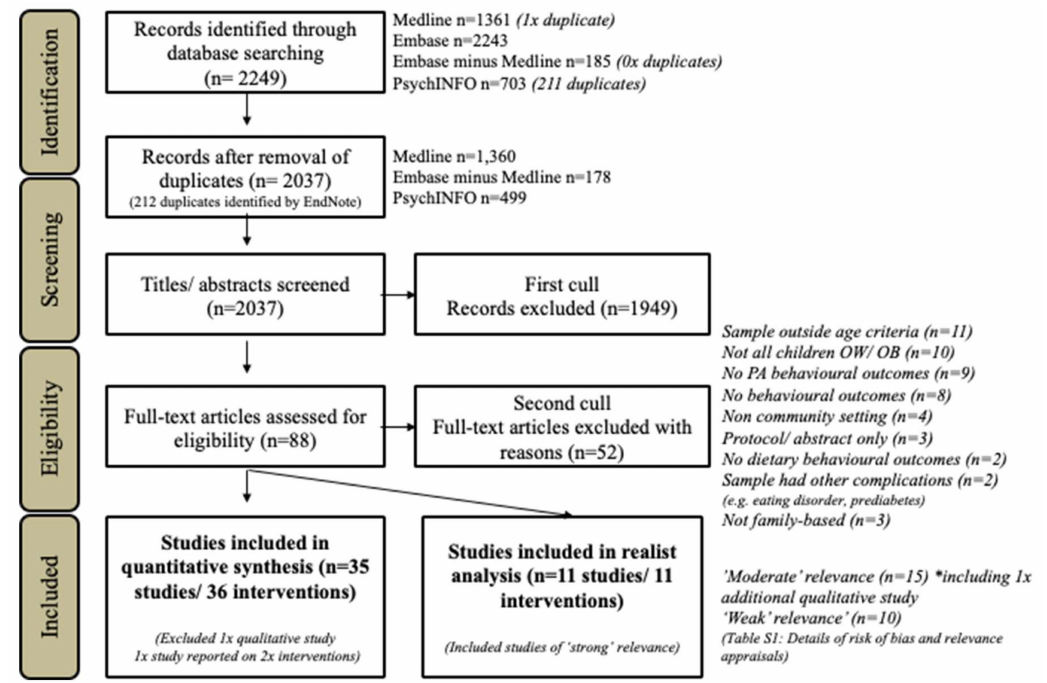
Figure 2. Study selection PRISMA flow